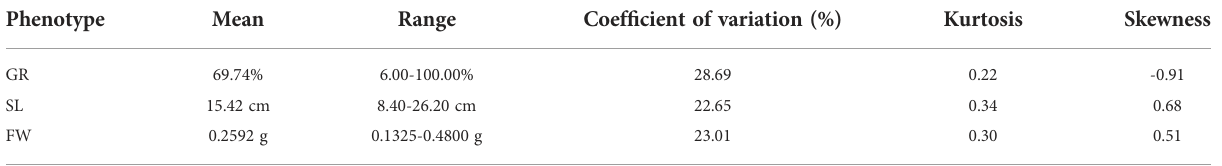
TABLE 1 The SV-related traits in 346 rice